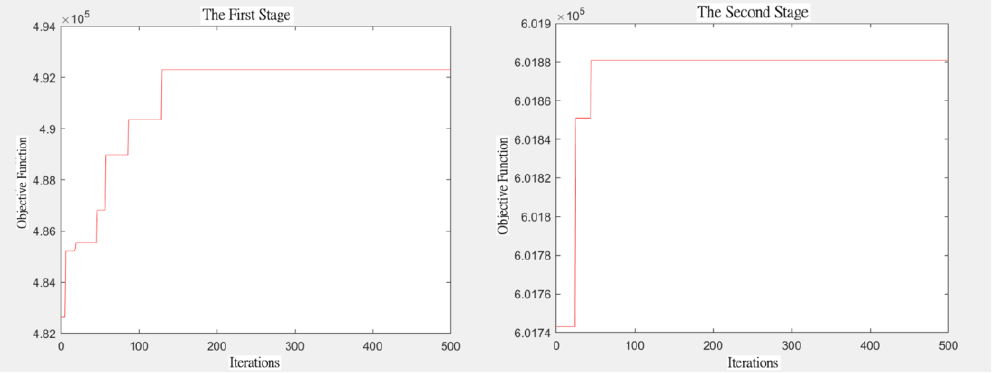
Figure 8. Schematic diagram of the iteration process for solving the model.